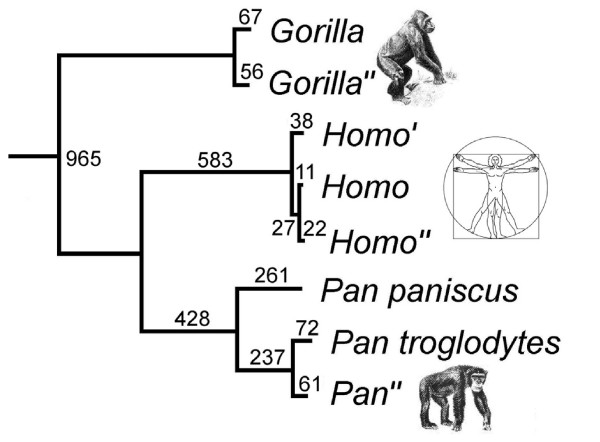
Phylogenetic relationships with and among Gorilla, Pan, and Homo, based on mitochondrial DNA genome sequences (without D-loops). The single minimum-length tree had a length of 2828. All nodes are supported in 100% of 10,000 bootstrap replications, Sequences marked (") are from the present paper. The unmarked sequences are from GenBank (Gorilla [NC_001645], Pan troglodytes [NC_001643], P. paniscus [NC_001644], and Homo [revised Cambridge Reference Sequence (rCRS): J01415.1]). The Homo sequence marked (') is from the individual (GenBank AF347008) identified in ref (12) as most divergent from the rCRS.